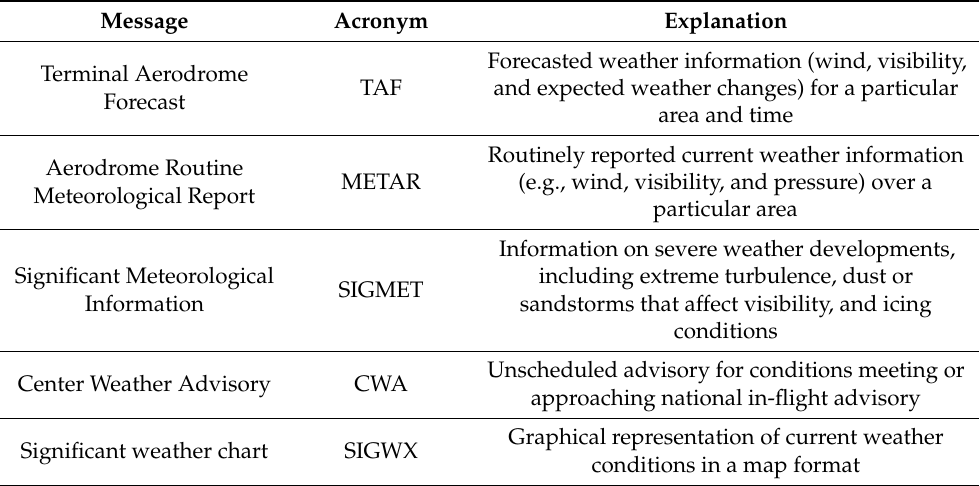
Table 1. Example weather messages received in the cockpit